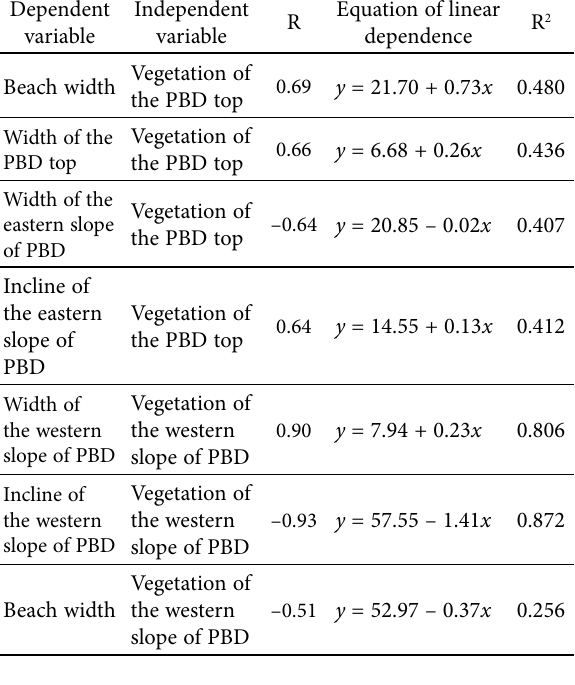
Table 1. The linear correlation relationships between the vegetation projection coverage and the beach morphometric parameters (made by the authors)